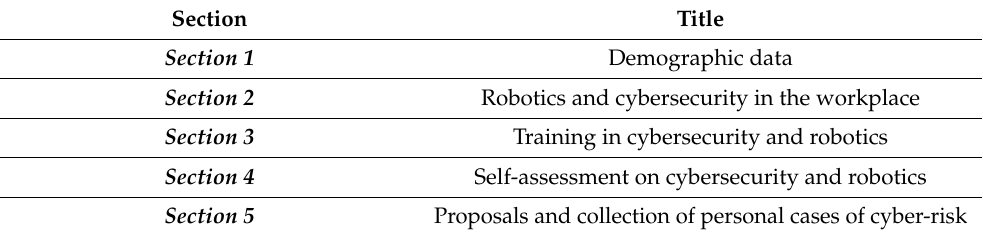
Table 2. Sections of the